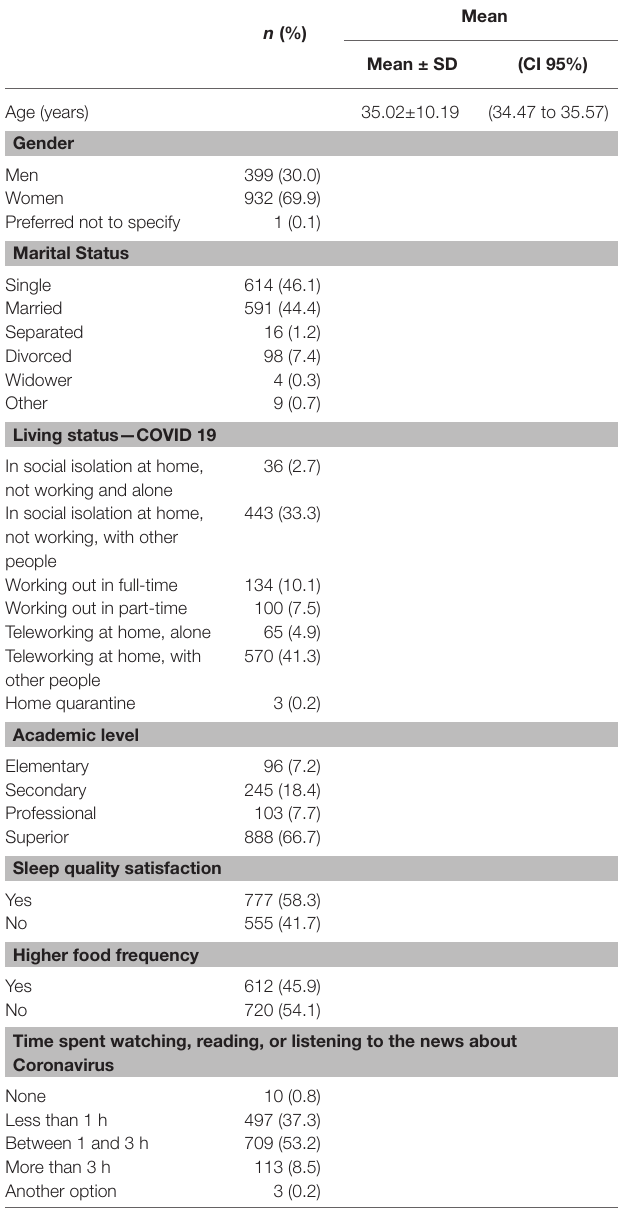
TABLE 1 | Summary of descriptive statistics ( n =